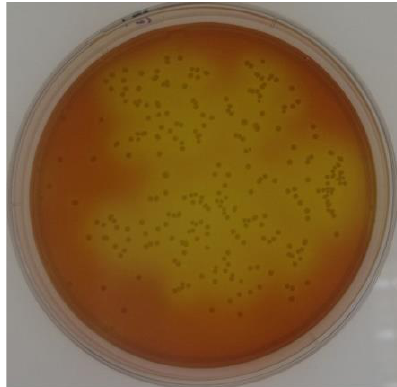
Figure 1. Colony morphology of A. oshimensis .